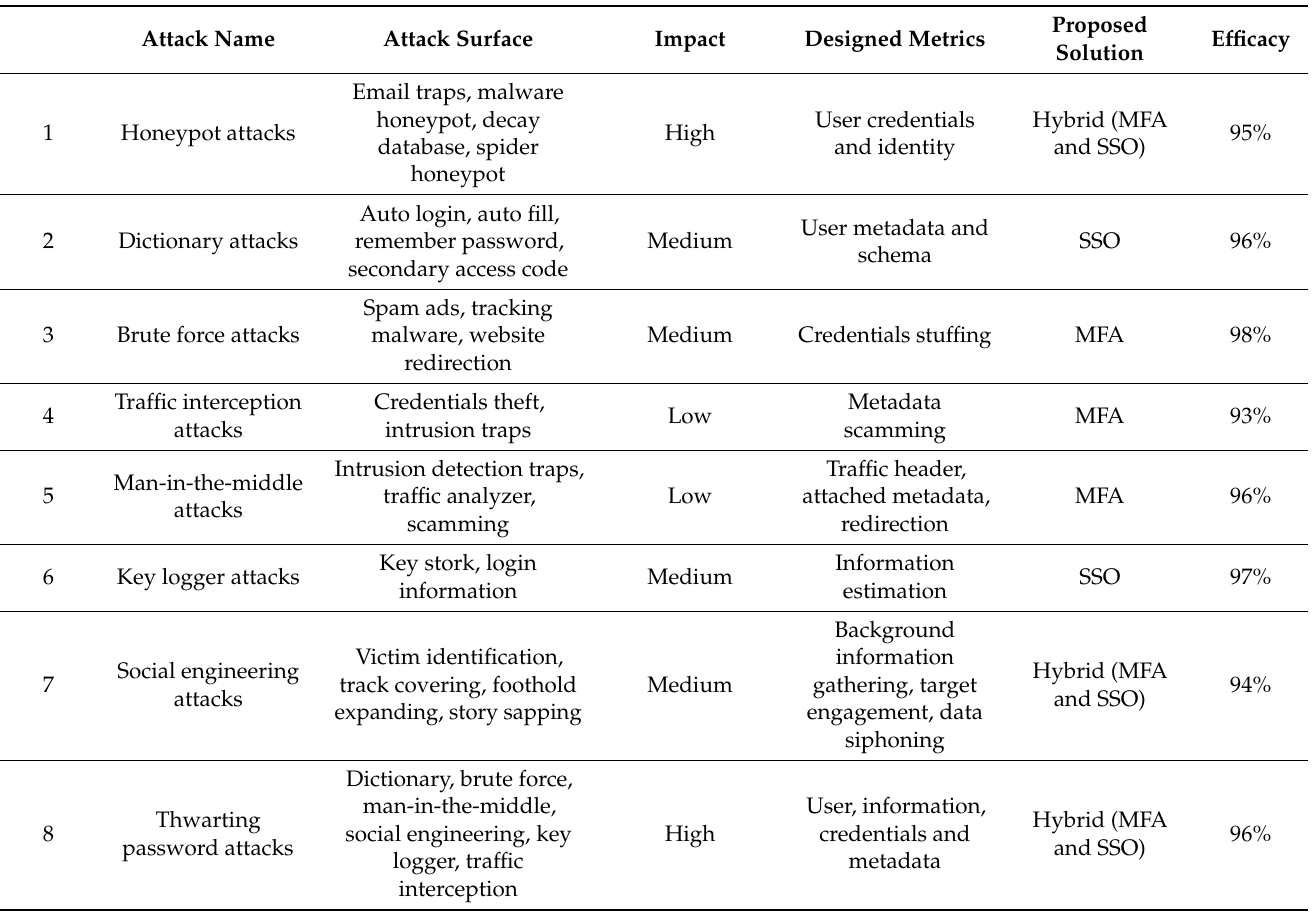
Table 2. Listed parameters and efficacy of the proposed work in terms of